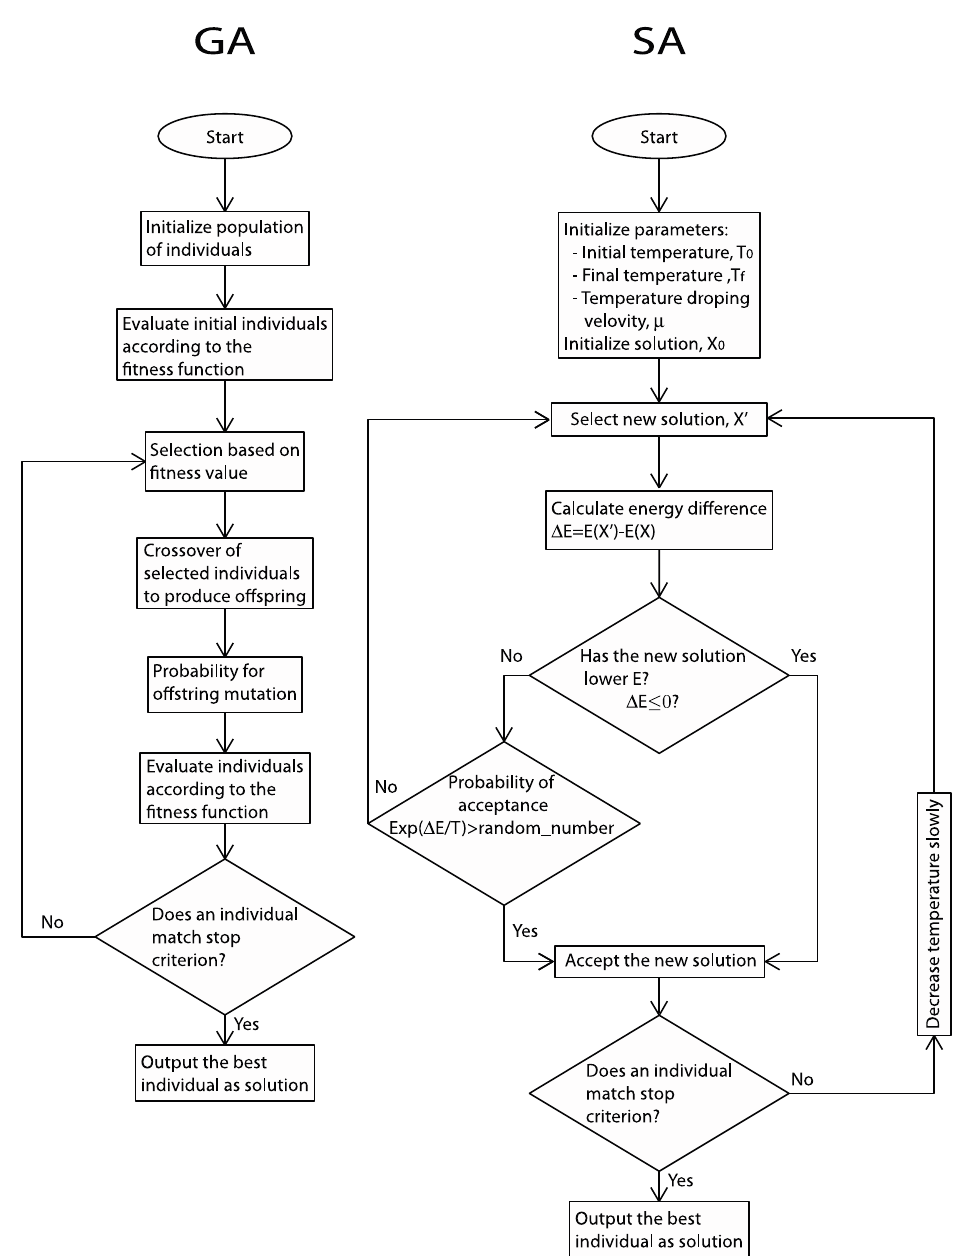
Figure 2. Workflow schemes for general genetic algorithms (GA) and simulated annealing (SA)